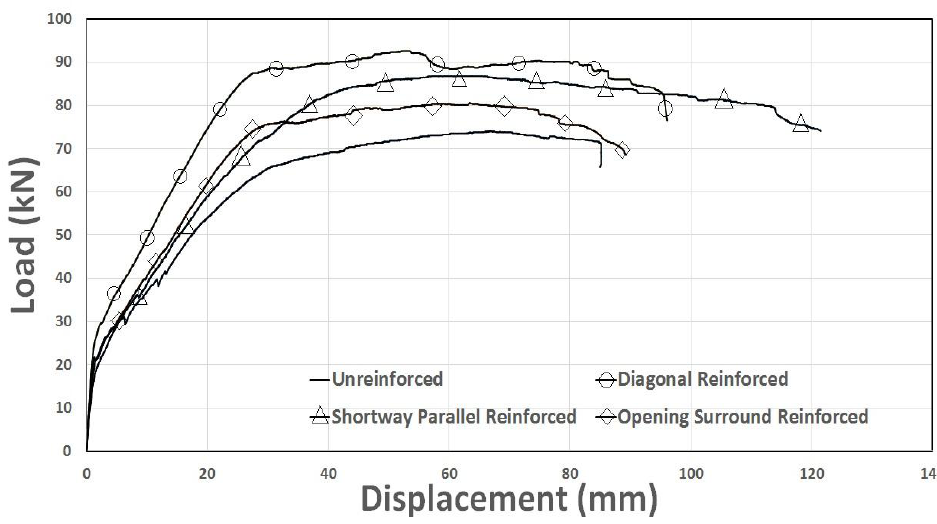
Figure 5. Load-deflection